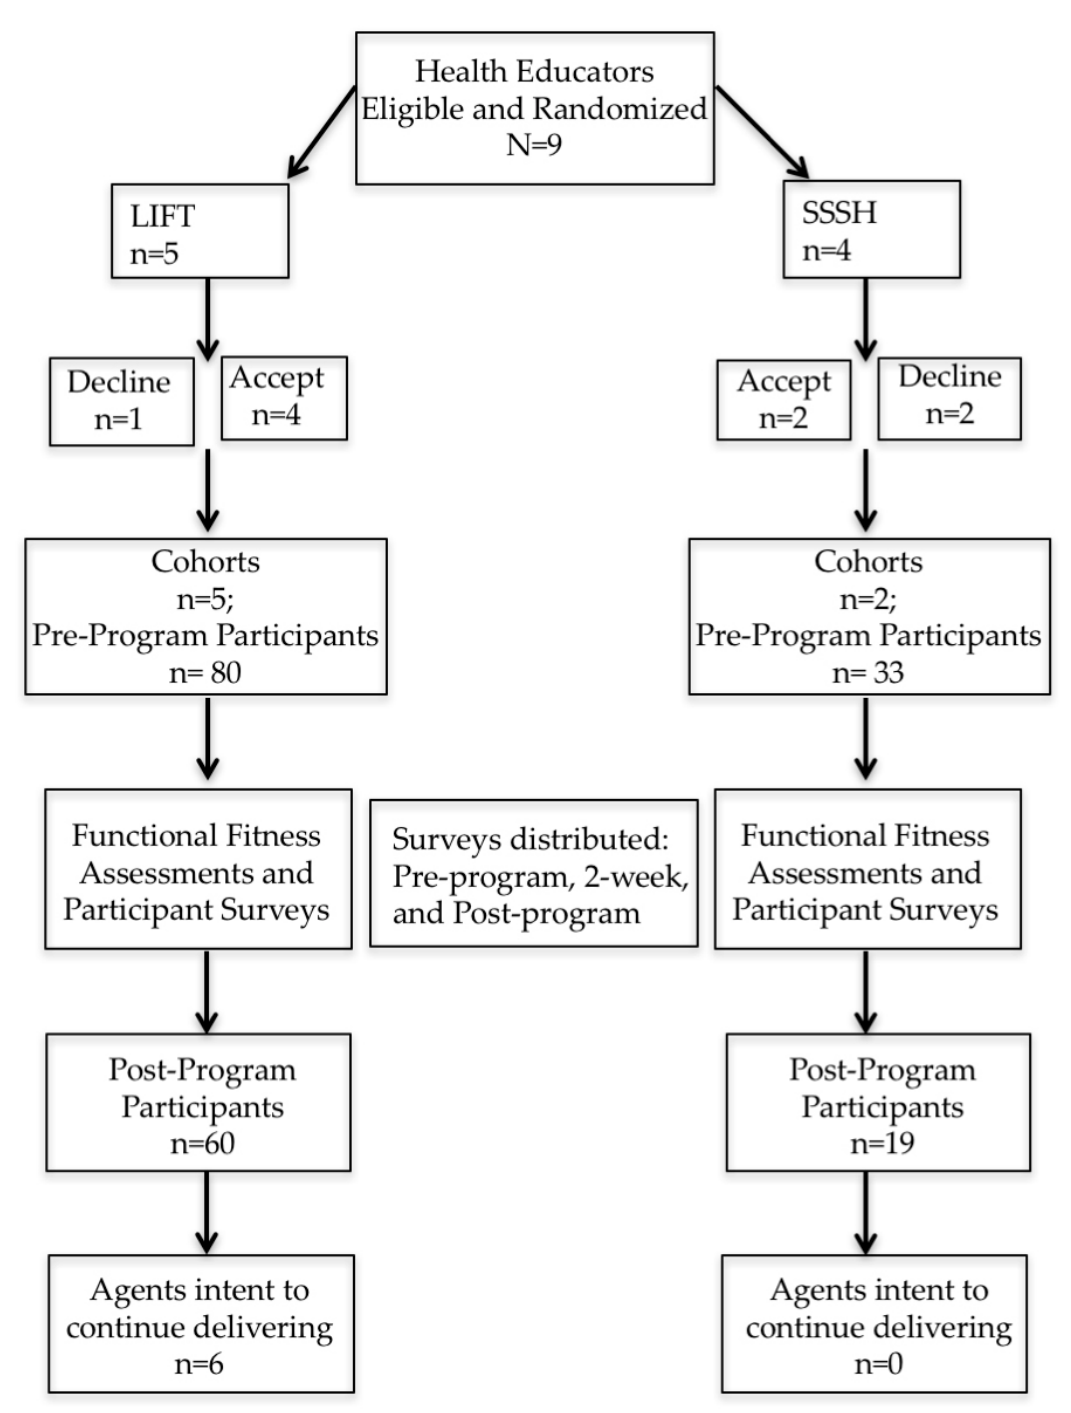
Figure 1. CONSORT diagram of the feasibility study design and outcomes based on the number of health educators who delivered LIFT or SSSH, the number of participants reached, assessment of functional fitness, participant retention rates, and number of health educators planning to deliver LIFT or SSSH in the future.